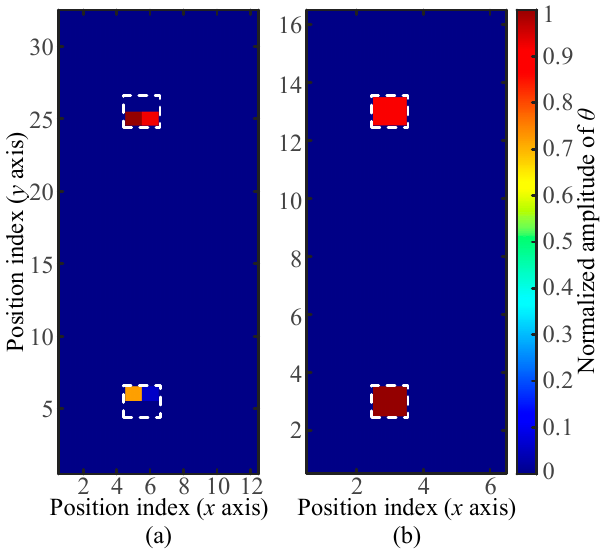
Figure 10. Localization results of two touches. ( a , b ) localization results, respectively, obtained with the reference database of A t = 4 mm 2 and σ a = 100 kPa and the reference database of A t = 16 mm 2 and σ a = 50